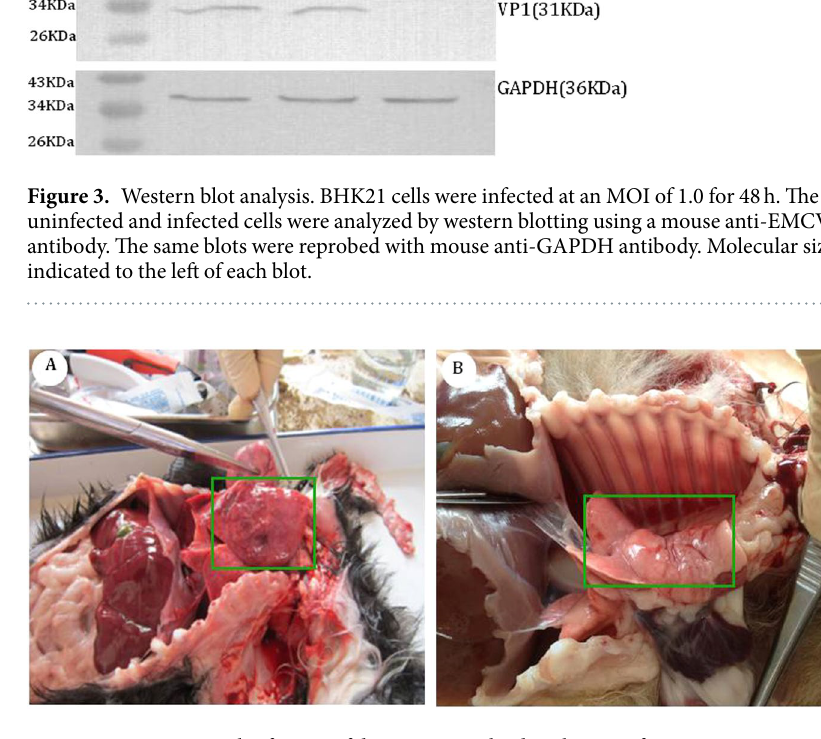
Figure 4. Experimental infection of dogs to assess the distribution of EMCV-C15 in various organs. Dogs in group A were challenged with EMCV-C15 and presented with pulmonary edema ( A ). The control dogs in group B, which were not inoculated with the virus, displayed no clinical signs ( B